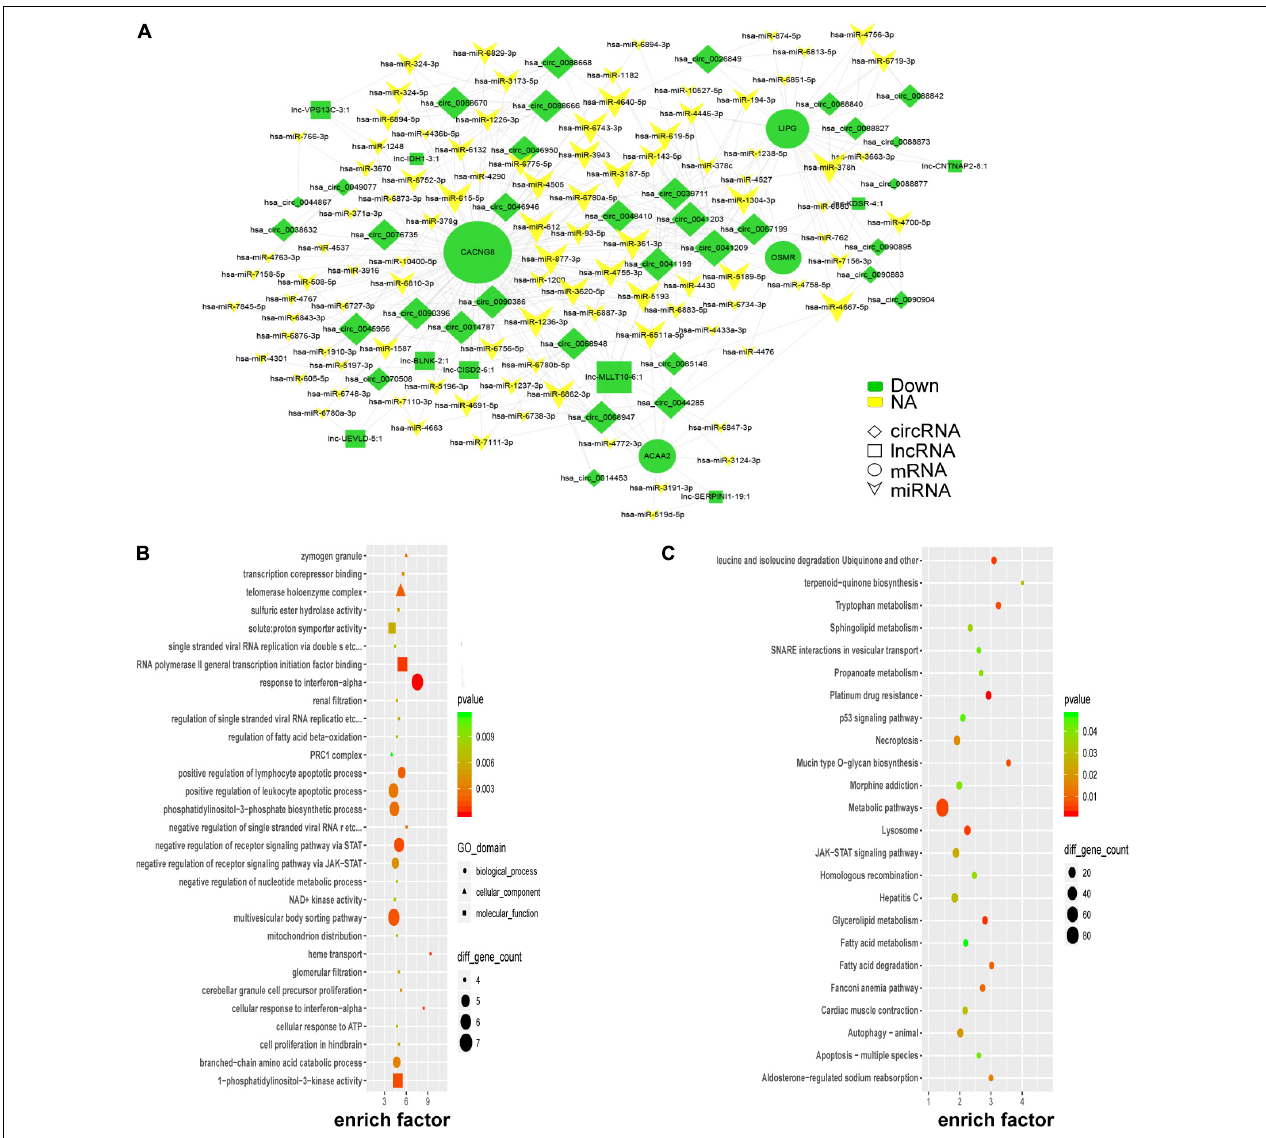
FIGURE 6 | Global ceRNA network integration in PE. A portion of the theoretical ceRNA network in PE was predicted according to the microarray analysis (A) . GO analysis of the molecules involved in the ceRNA network (B) . KEGG pathway analysis of the molecules involved in the ceRNA network (C) .